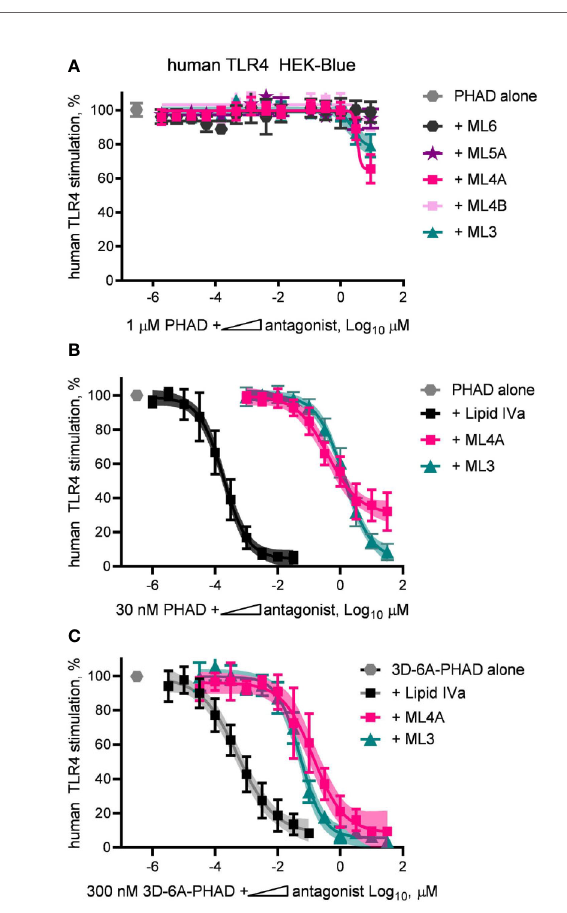
FIGURE 6 | Inhibition of human TLR4 by tetra- and tri-acylated components of MPL adjuvant. Synthetic versions of several major components of MPL adjuvant ® were tested for inhibitory activity using human TLR4 HEK-Blue reporter cells. (A) MPL adjuvant ® components ML3, ML4A, ML4B, ML5A and ML6 were diluted in half-log steps in a mixture containing a fi xed concentration of PHAD (1 m M) and added to human TLR4 HEK-Blue reporter cells for 22 h. Values shown are averages ± SD of secreted alkaline phosphatase from two independent experiments, each performed in triplicate and normalized by setting 100% = PHAD alone (1 m M). (B, C) MPL adjuvant ® components ML3 and ML4A were diluted from a peak dose of 31.6 m M (or a peak dose of 0.03 m M Lipid IVa as antagonist control) in half-log steps in a mixture containing a fi xed concentration of PHAD (30 nM) or 3D-6A-PHAD (300 nM), respectively. Values shown are averages ± SD of secreted alkaline phosphatase from two independent experiments normalized by setting 100% = PHAD or 3D-6A-PHAD alone, respectively. Shaded regions indicate 99% con fi dence intervals within which the true population means should occur 99% of the time. Calculated IC50 PHAD values (95% CI) were: ML3, 1.32 m M (1.08 – 1.67); ML4A, 0.40 m M (0.27 – 0.62); and Lipid IVa: 0.19 nM (0.15 – 0.23).